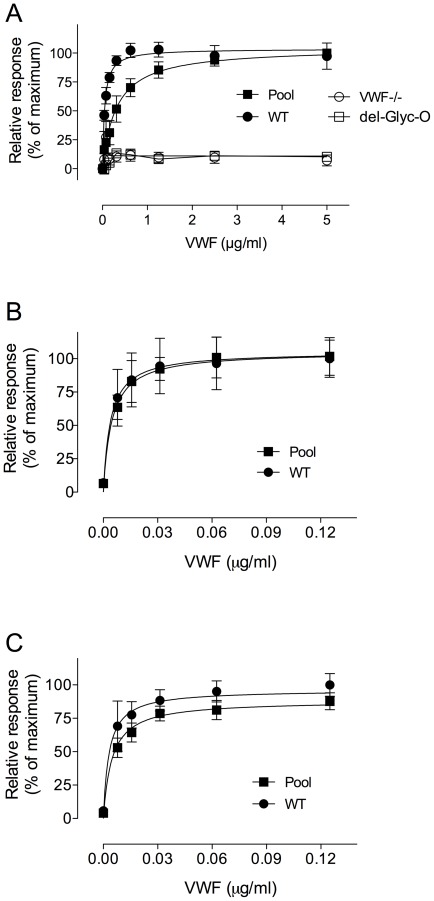
Detection of T antigen on VWF in murine plasma.Microtiter wells coated with polyclonal anti-VWF antibodies (3 µg/ml) were incubated with serial dilutions of murine plasma previously adjusted for VWF concentration. After catching VWF, wells were incubated with neuraminidase (5 mU/ml) in PBS/1 mM CaCl2 overnight at 37°C (neuraminidase incubation was omitted for data presented in panels B and C). Subsequently, wells were blocked with the avidin/biotin blocking kit and incubated for 2 hours at 37°C with btPNA (panel A), btECL (panel B) or btWGA (panel C). After washing, HRP-conjugated streptavidin was added to the wells and bound lectin was detected by measuring HRP activity using OPD as a substrate. Panel A: btPNA binding to pooled plasma of C57Bl6J mice (Pool), plasma of WT-VWF expressing mice (WT), plasma of Del-O-Gly expressing mice (Del-O-Gly) and plasma of VWF-deficient mice (VWF−/−); Panel B: btECL binding to Pool and WT; Panel C: btWGA binding to Pool and WT. Plotted is the relative response (% of maximum binding) versus concentration of VWF in diluted samples. The relative response is defined as binding being relative to binding of the lectins to WT VWF (5 µg/ml for btPNA and 0.125 µg/ml for btECL and btWGA), which was arbitrarily set at 100%. Data points represent the mean±SD of 3–6 measurements.